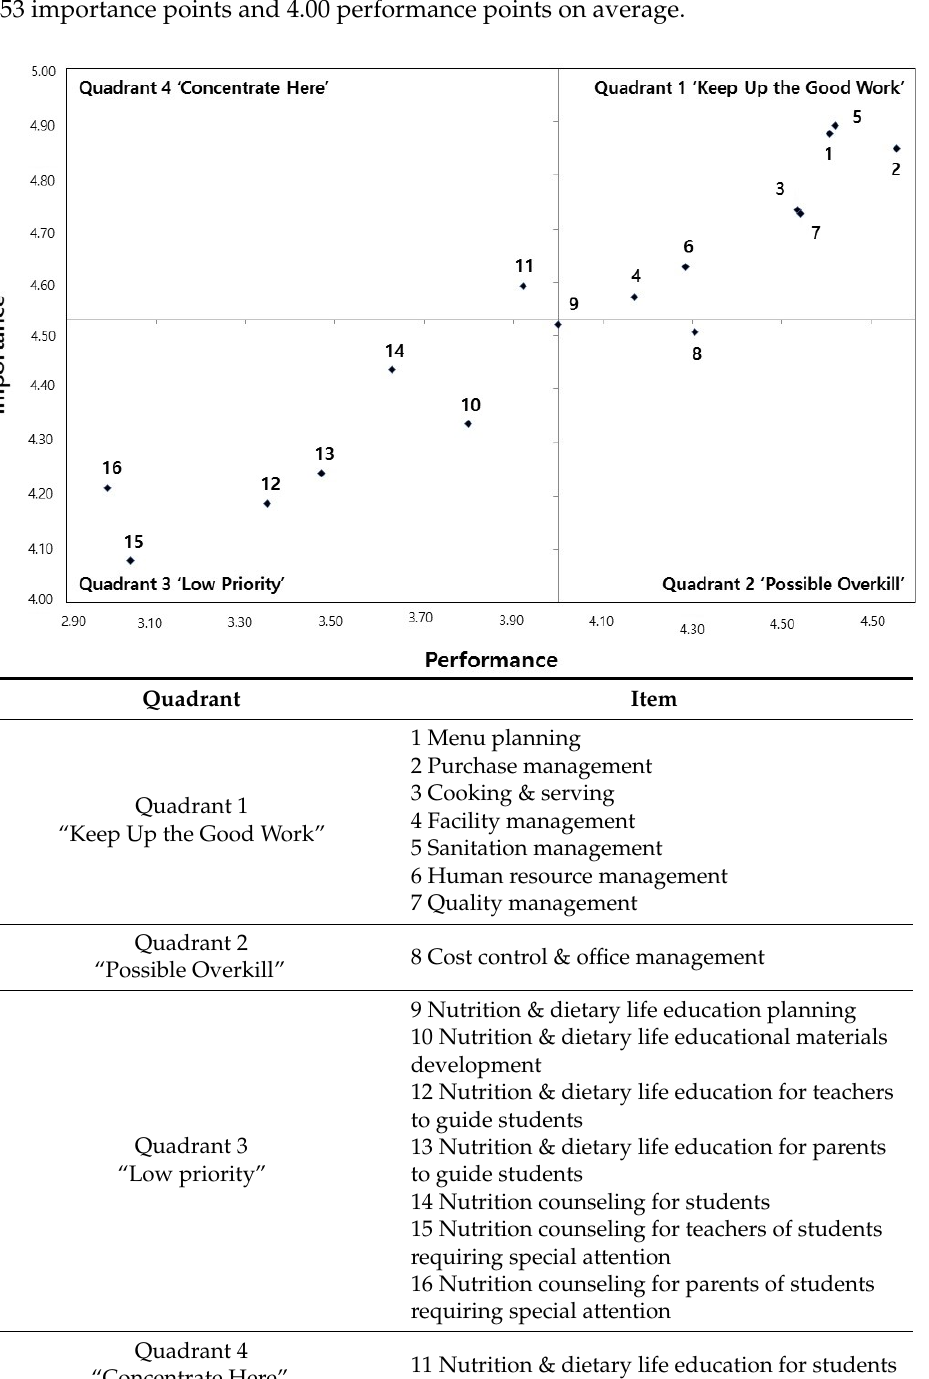
Figure 1. Importance–performance analysis of nutrition teachers’ and dietitians’ tasks.